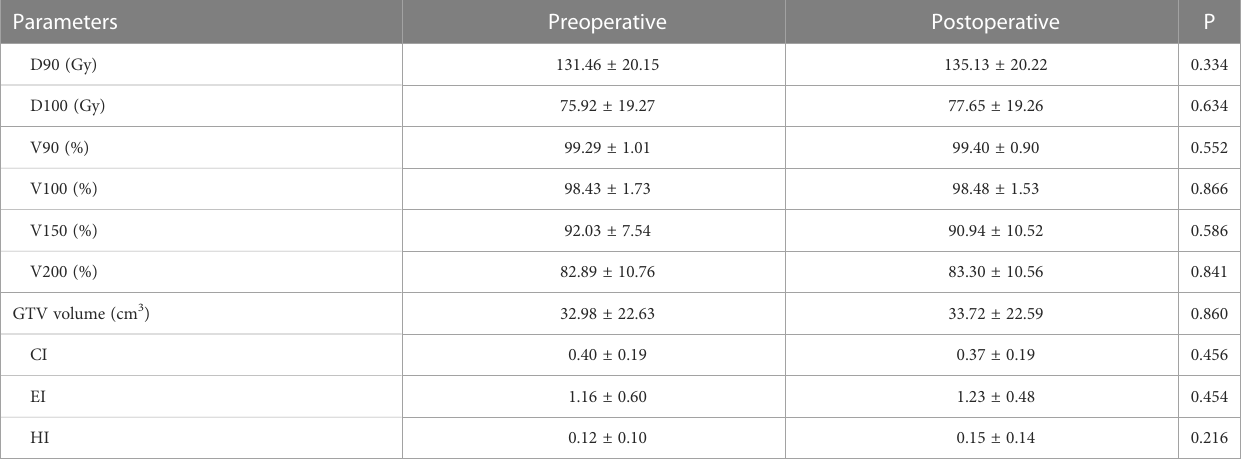
TABLE 3 Comparison of preoperative and postoperative dosimetry parameters of 76 lesions in 58 patients ( (cid:1) x ± s). Parameters